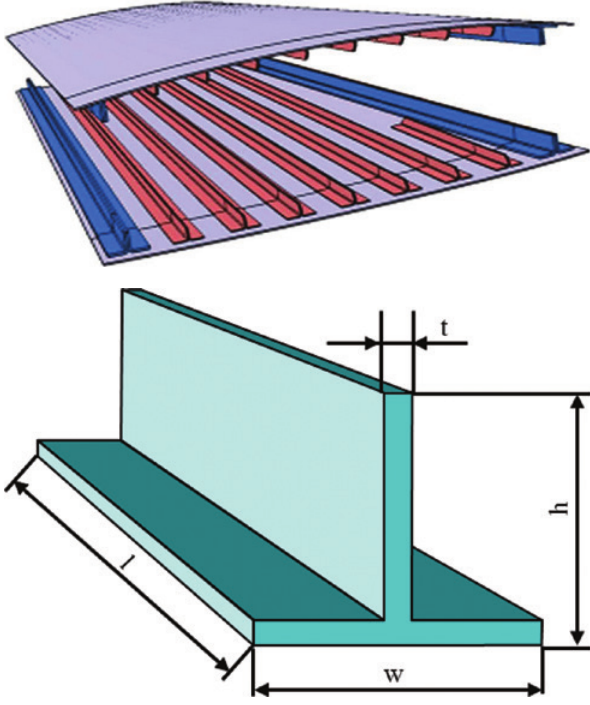
Figure 12: Example of a structural aeronautic component composed of stringer-reinforced panels (top) and geometric parameters of the T-shaped stringers